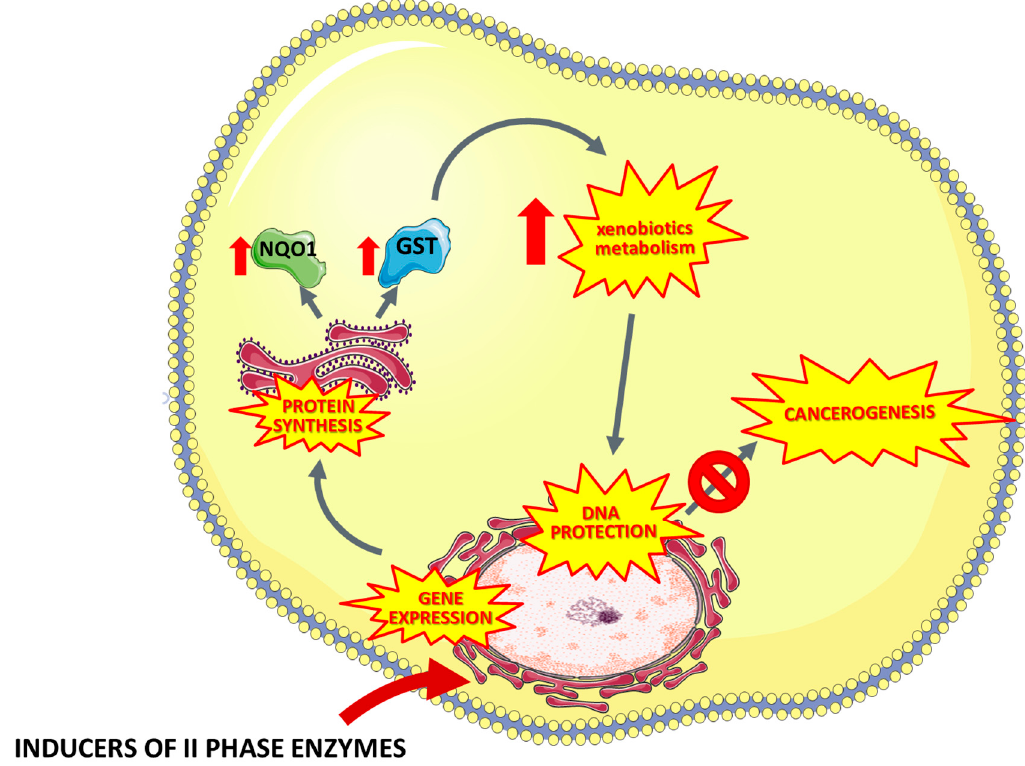
Figure 1. Mechanisms of the chemopreventive activity of the phase II detoxification enzymes (such as organosulfur compounds indole-3-carbinol, isothiocyanates, sulforaphan, glucoraphanin, iberin, phenolic compounds, terpenes, coumarins) leading to inhibition of carcinogenesis. NQO1—